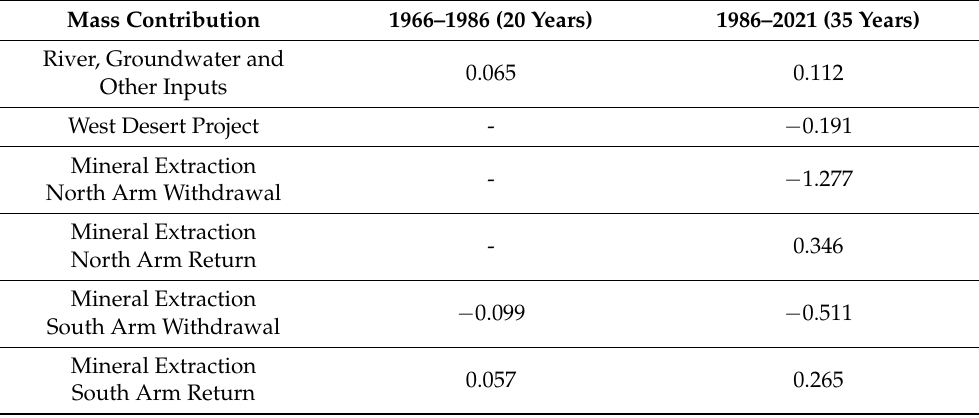
Estimated cumulative contributions to the total salt mass calculations before (May 1966–September 1986) and after (October 1986–December 2021) the maximum mass in 1986. Values are in billion metric